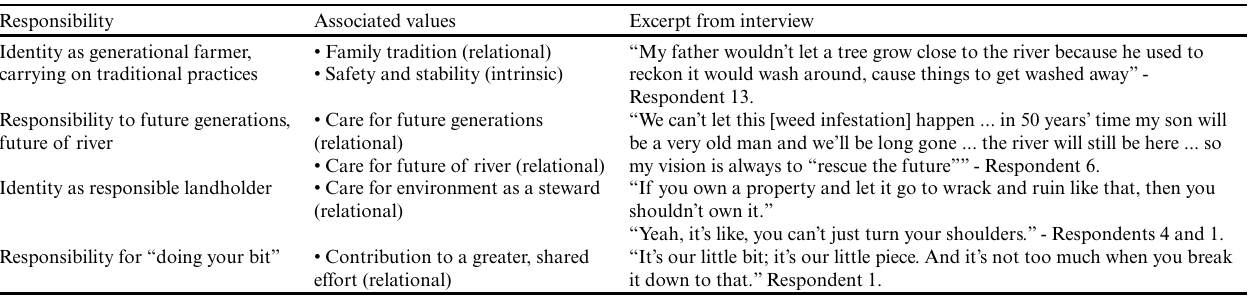
Table 4 . Motivating responsibilities.